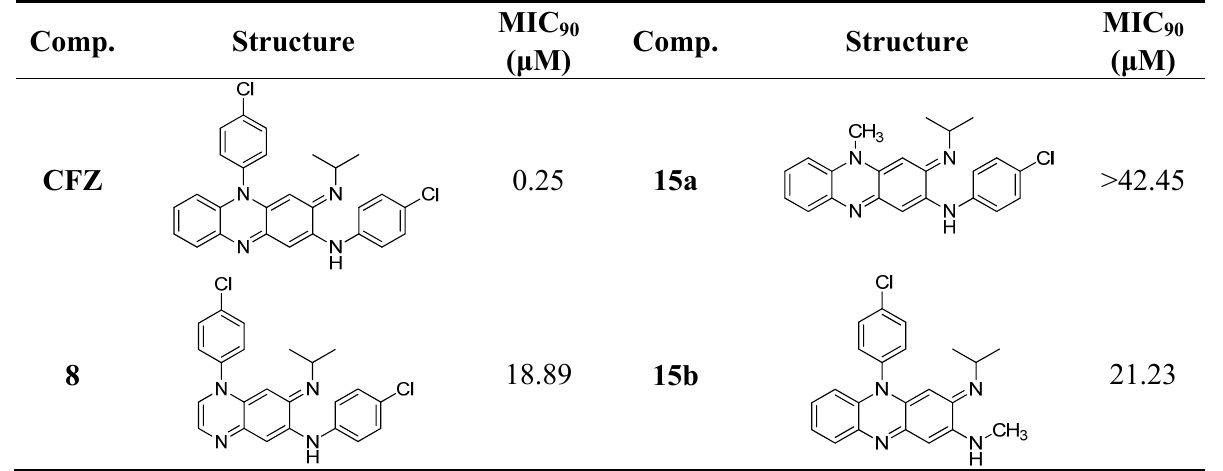
Table 1. In vitro anti-tuberculosis activity of the riminophenazine analogues with systematic deletion of one of the phenyl rings against M. tuberculosis H